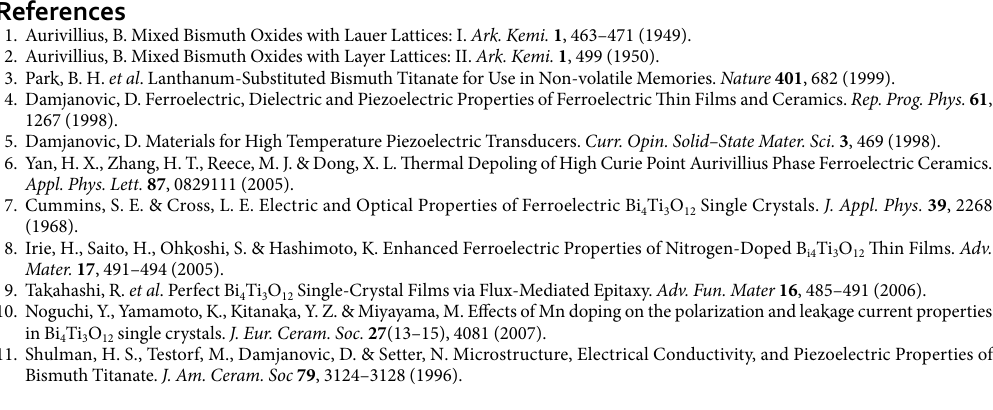
13 Scientific RepoRts | 7: 4193 | DOI:10.1038/s41598-017-03266-y